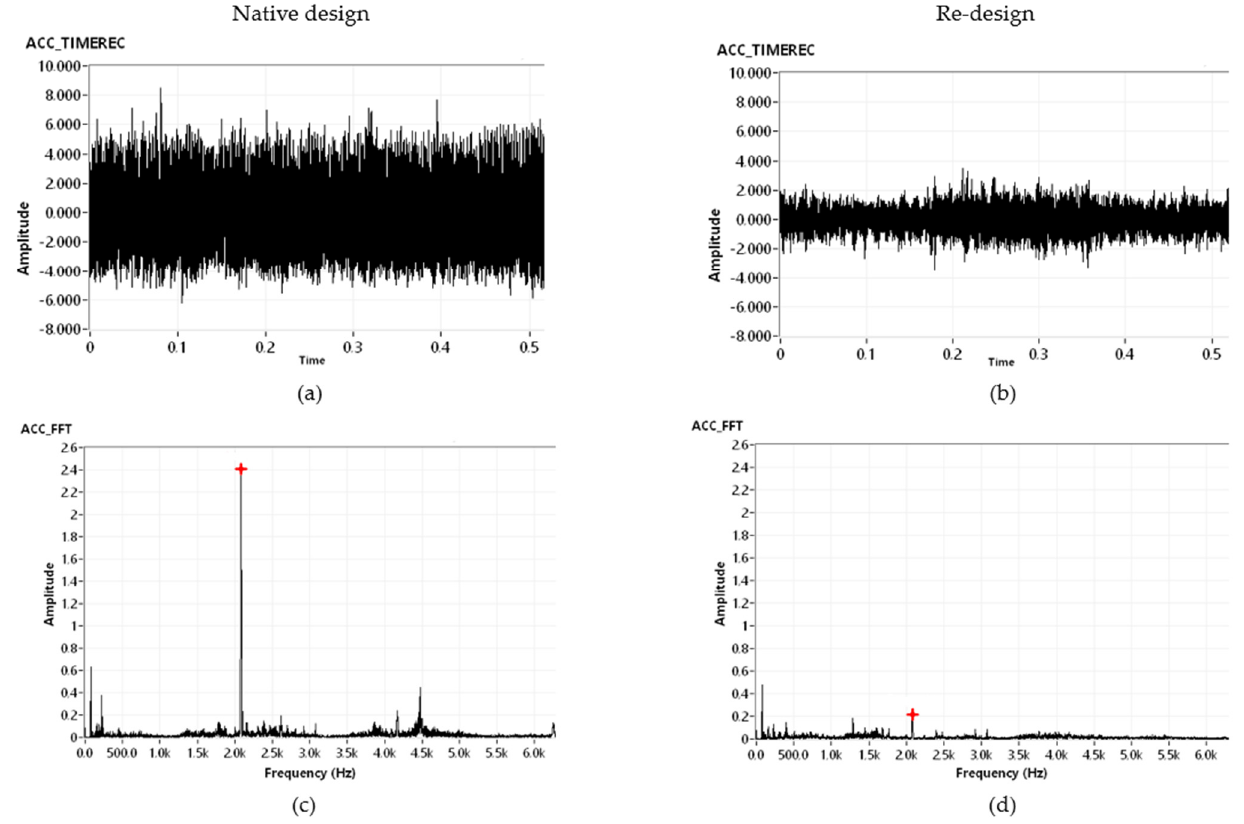
Figure 9. Comparison of time recording of ( a ) native design and ( b ) re-design, and comparison of FFT spectrum of ( c ) native design and ( d ) re-design.